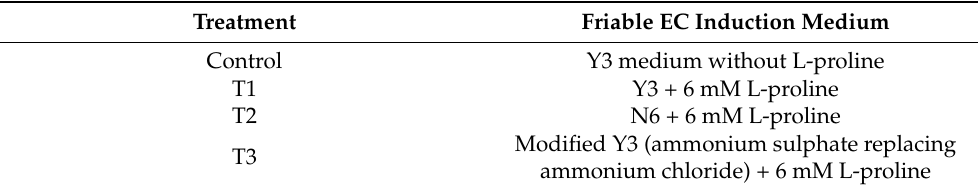
Table 5. Different treatments for the induction of friable embryogenic callus (EC) from plumule tissues cultured in either Y3 or N6